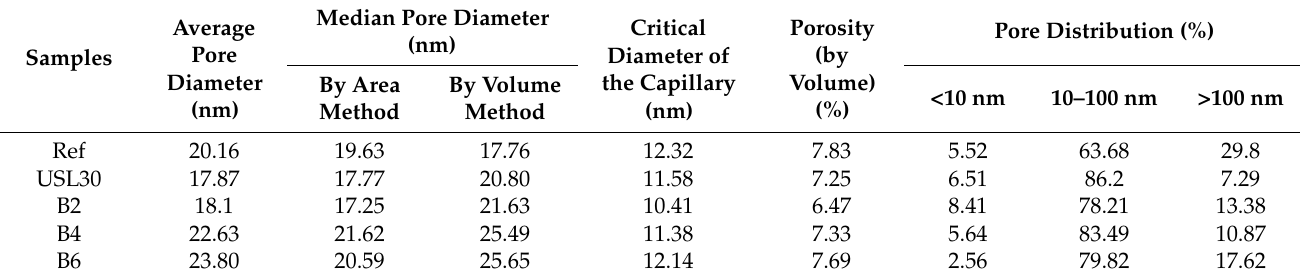
Table 5. Pore distribution of the UHPC.